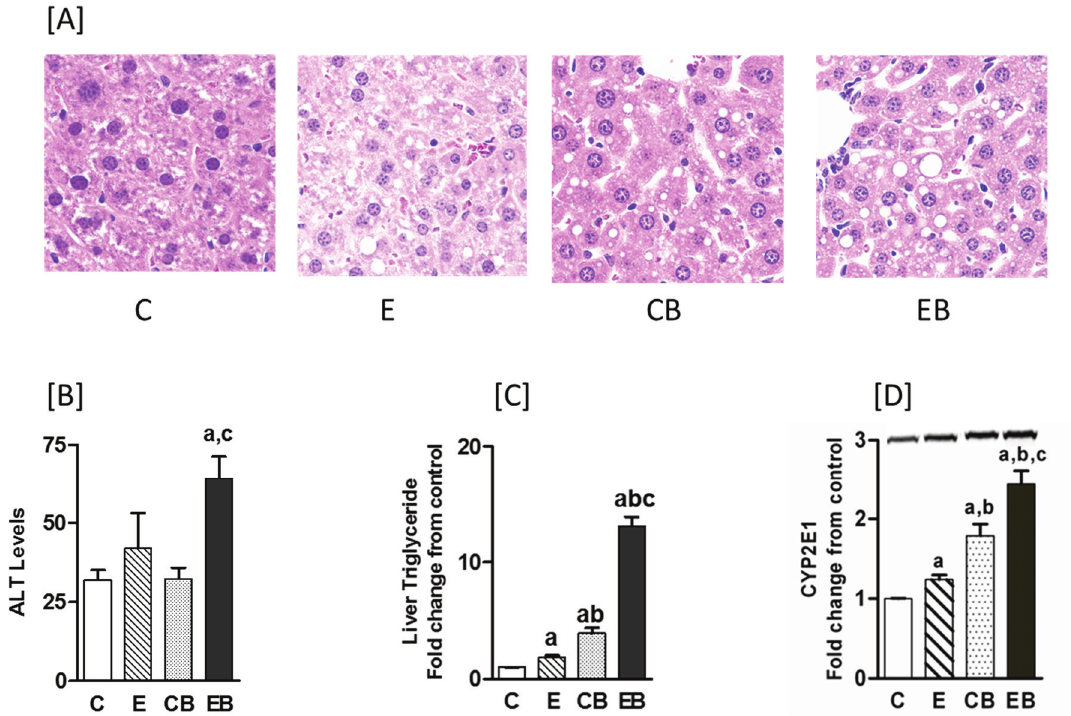
Figure 1. Hepatic steatosis, serum ALT, and CYP2E1 levels in chronic ethanol and binge treated mice. The chronic ethanol feeding (four weeks) and three repeat binge treatment was performed as described under “Experimental Section”. ( A ) Hepatic steatosis: sections of liver samples were stained with hematoxylin and eosin; ( B ) Serum ALT levels; ( C ) Liver triglyceride levels; ( D ) CYP2E1 protein measured by western blotting (representative blot images shown above the histogram). Values are mean ± SE ( n = 3 to 4 mice). a: significant compared to control ( p < 0.05); b: significant from chronic ethanol group ( p <